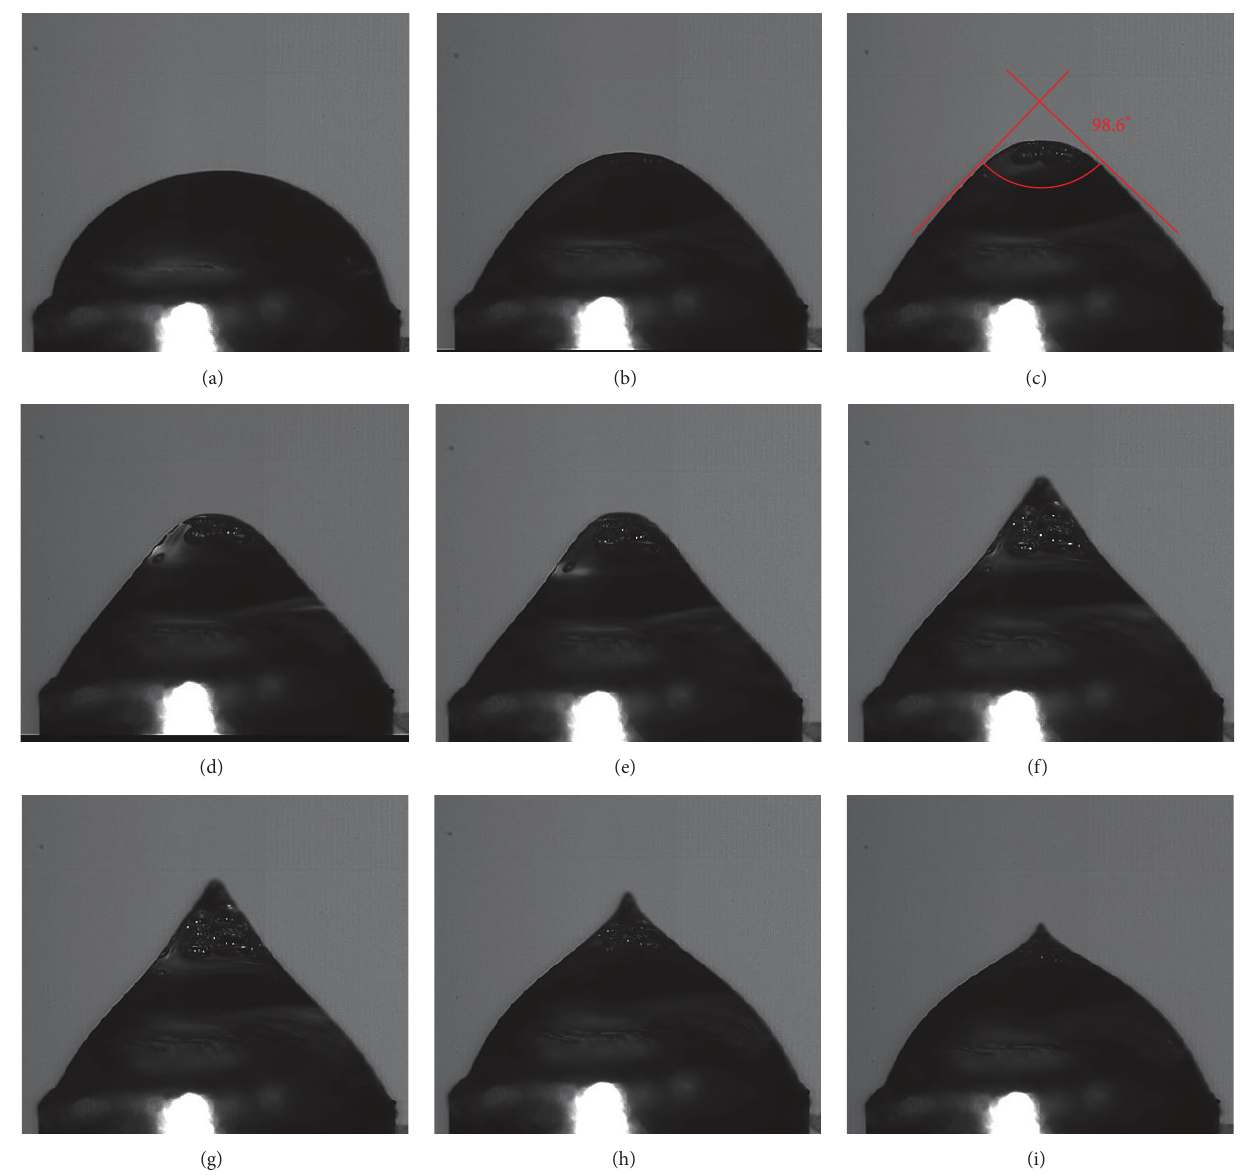
Figure 2: The Taylor cone formation from the free polymeric layer and the start of the electrospinning process: Taylor cone formation (a–c) and relaxation of polymeric droplet (d–i). Start of the spinning process (i). Reaction of electric and capillary forces can be observed. The angle of the Taylor cone 𝛾 (c). Needle electrospinning of 12wt.% PVA, 𝑈 = 30kV. Electrospinning was carried out at laboratory conditions.